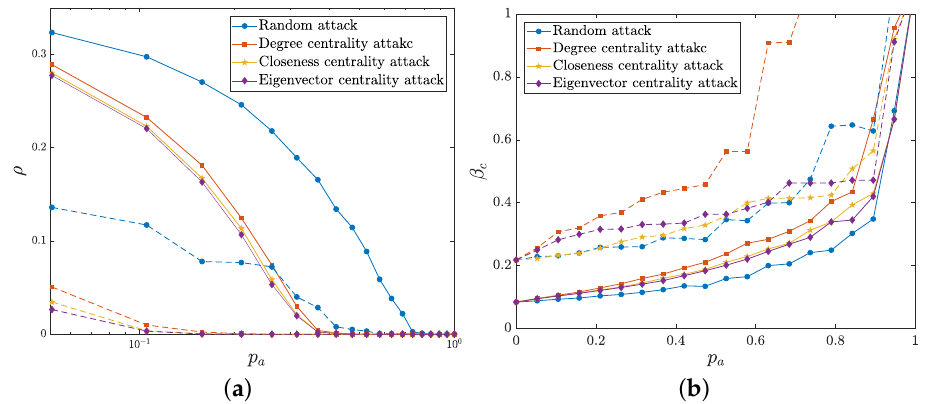
Figure 8. The I-state density ρ ( a ) and the epidemic threshold β c ( b ) as functions of the attacked node proportion p a under four attack strategies. The solid and dashed lines represent the variation of the group-based multilayer network and the multiplex network, respectively, where the lines in the same color indicate the same attack strategy. Other parameters are fixed as γ = 0.1, λ 1 = η = µ = 0.9, β = τ = δ = λ 2 = 0.5, ι = 1.1, and ¯ x = ¯ y =